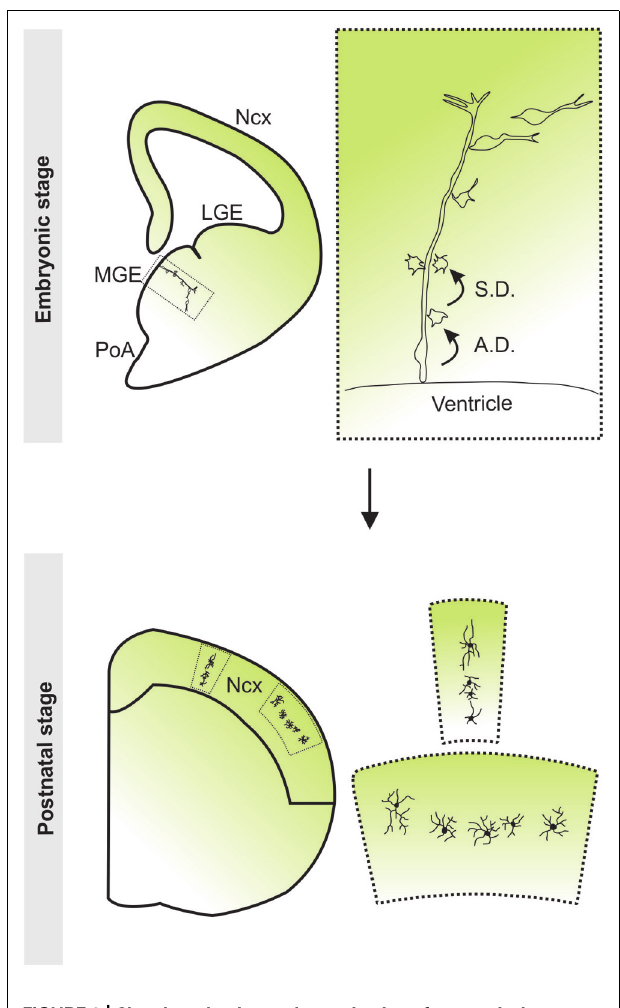
FIGURE 3 | Clonal production and organization of neocortical interneurons. Radial glial progenitor cells divide asymmetrically at the ventricular zone surface to self renew and to simultaneously produce differentiating interneurons or intermediate progenitor cells which then divide symmetrically in the subventricular zone to produce differentiating interneurons.The progeny of the same radial glial progenitor cell initially migrate along the mother radial glial cell and form radially aligned clonal clusters. As development proceeds, the early-born cells progressively move away from the ventricular zone, acquire the characteristic morphological and biophysical features of differentiating interneurons, and migrate tangentially towards the neocortex. After arriving at their destination in the neocortex, inhibitory interneuron clones do not randomly disperse, but form spatially organized vertical or horizontal clusters. Ncx, neocortex; LGE, lateral ganglionic eminence; MGE, medial ganglionic eminence; PoA, preoptic